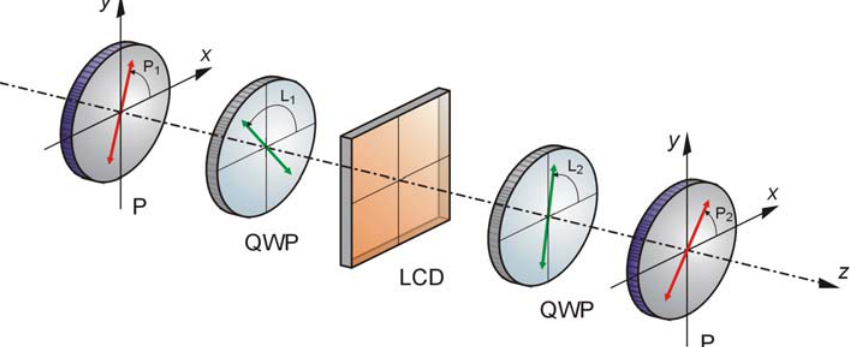
Figure 1. Phase-only modulation experimental setup with a VPTNLC. P: polarizer; QWP: a quarter-wave plate. In the diagram, the x-axis coincides with the input molecular director of the liquid crystal cell. P1 and P2 are, respectively, the orientation of the polarizer and the analyzer. L1 and L2 are the angles of the slow axis of the quarter-wave plates with respect to